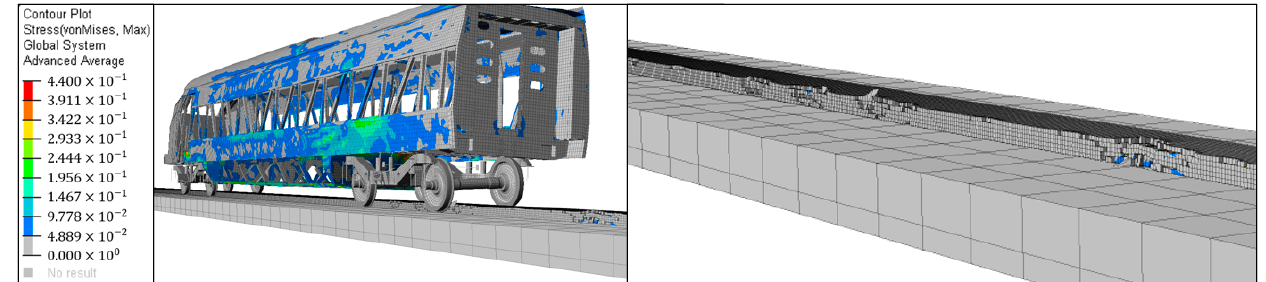
Figure 15. Collision behaviors of the vehicle (top view) [R3500, 300 km/h].